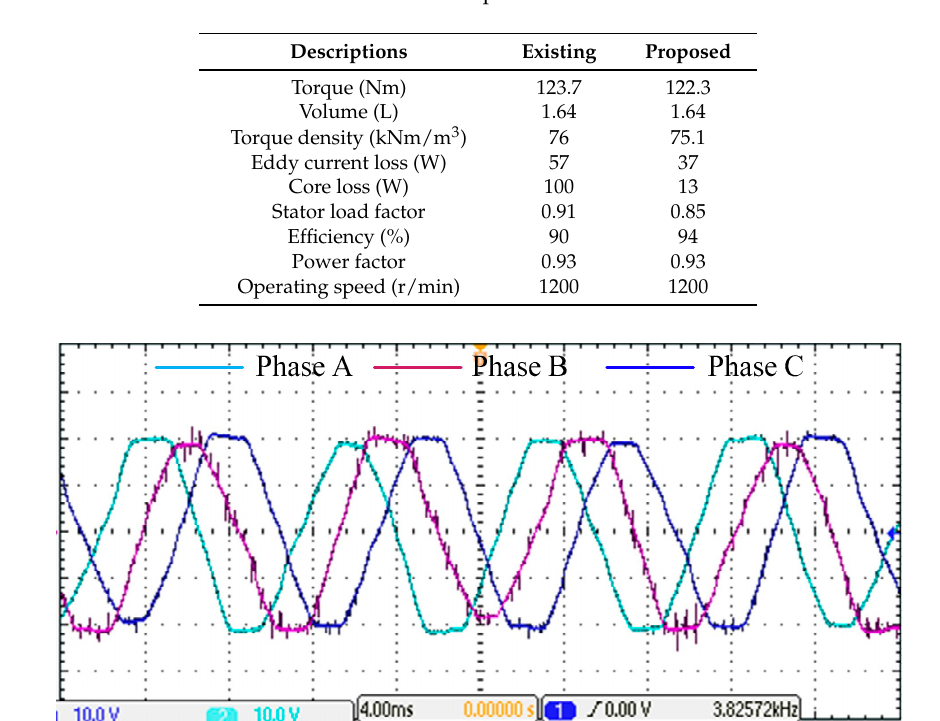
Figure 15. Back-EMF waveforms: ( a ) proposed and ( b ) existing. Table 3. Performance comparison of two machines.